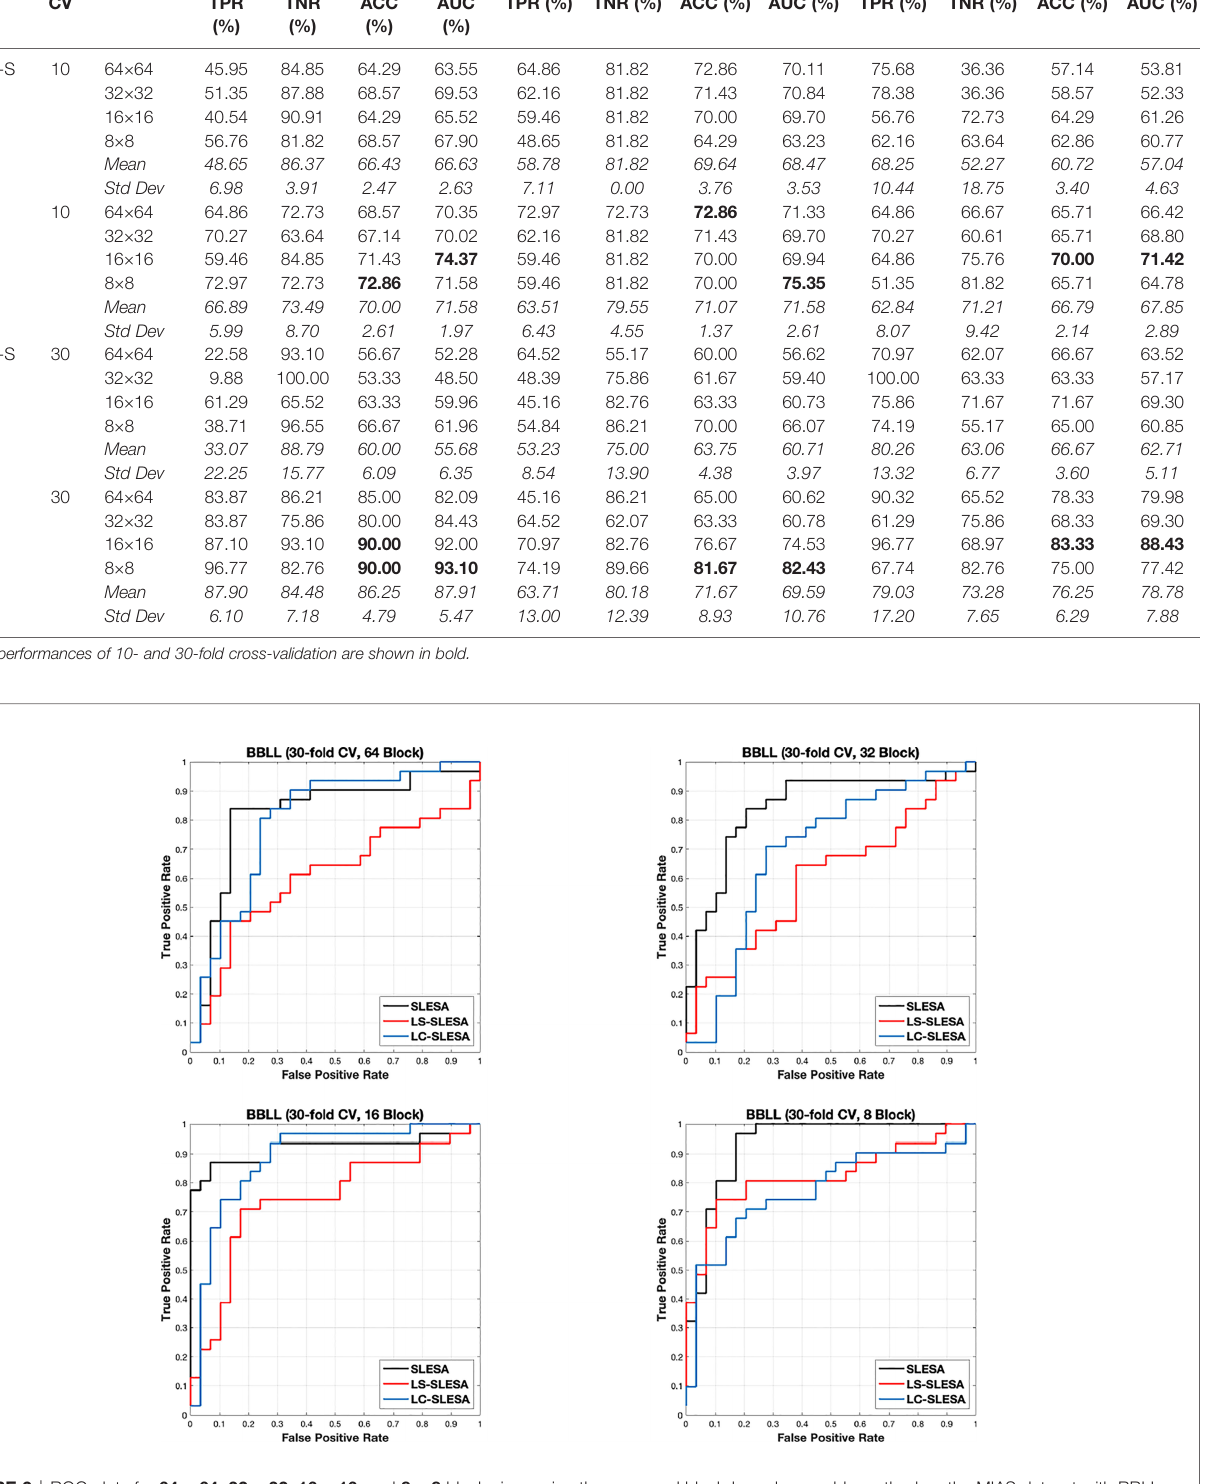
FIGURE 2 | ROC plots for 64 × 64 , 32 × 32 , 16 × 16 , and 8 × 8 block sizes using the proposed block-based ensemble method on the MIAS dataset with BBLL decision functions and 30-fold